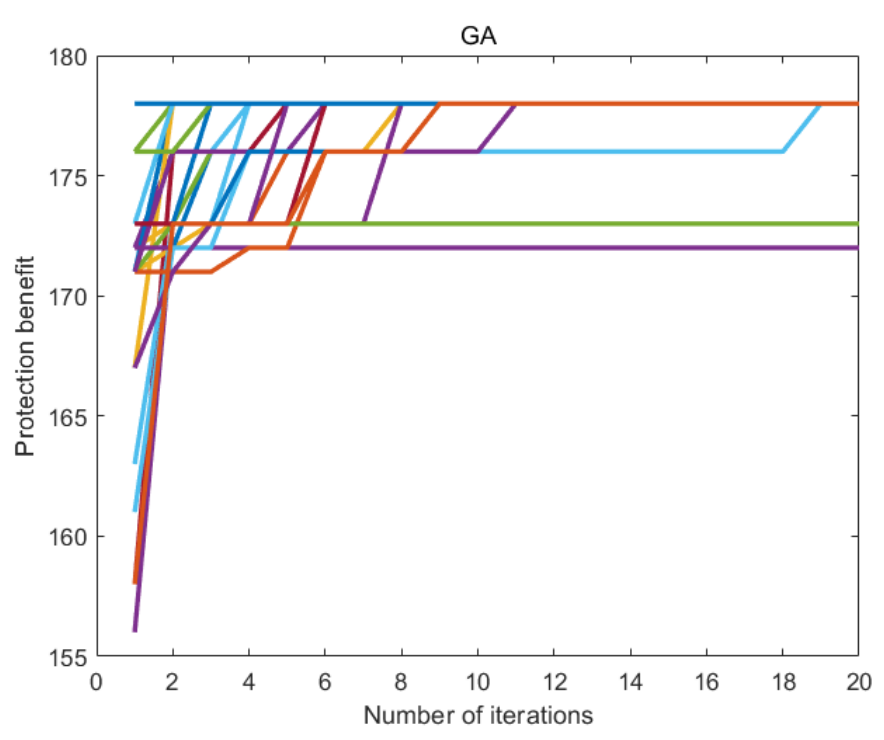
Figure 11. Population size is 100, and the GA algorithm is run 100 times.